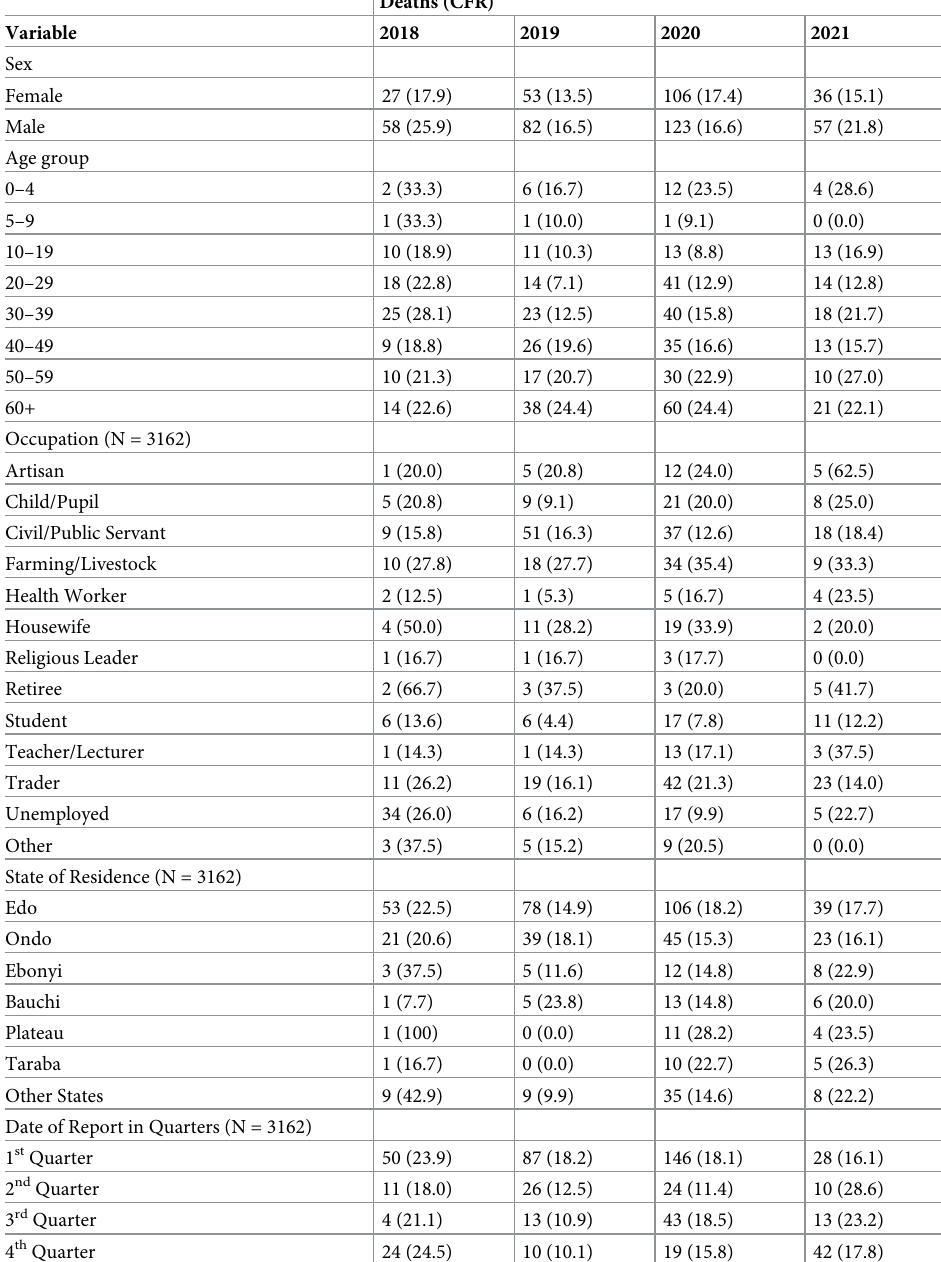
Table 2. Case fatality rates by key socio-demographic characteristics,